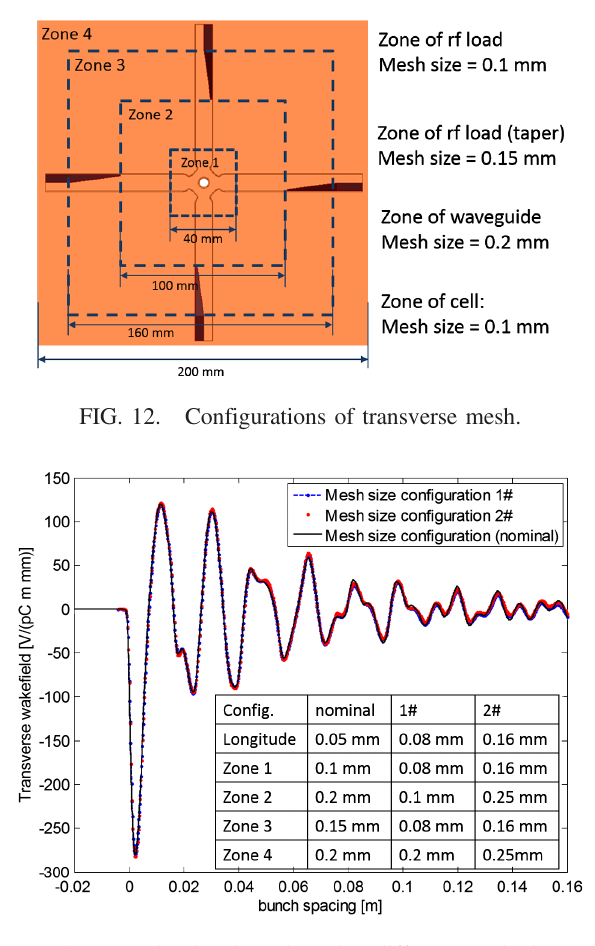
FIG. 13. Simulated results using different mesh